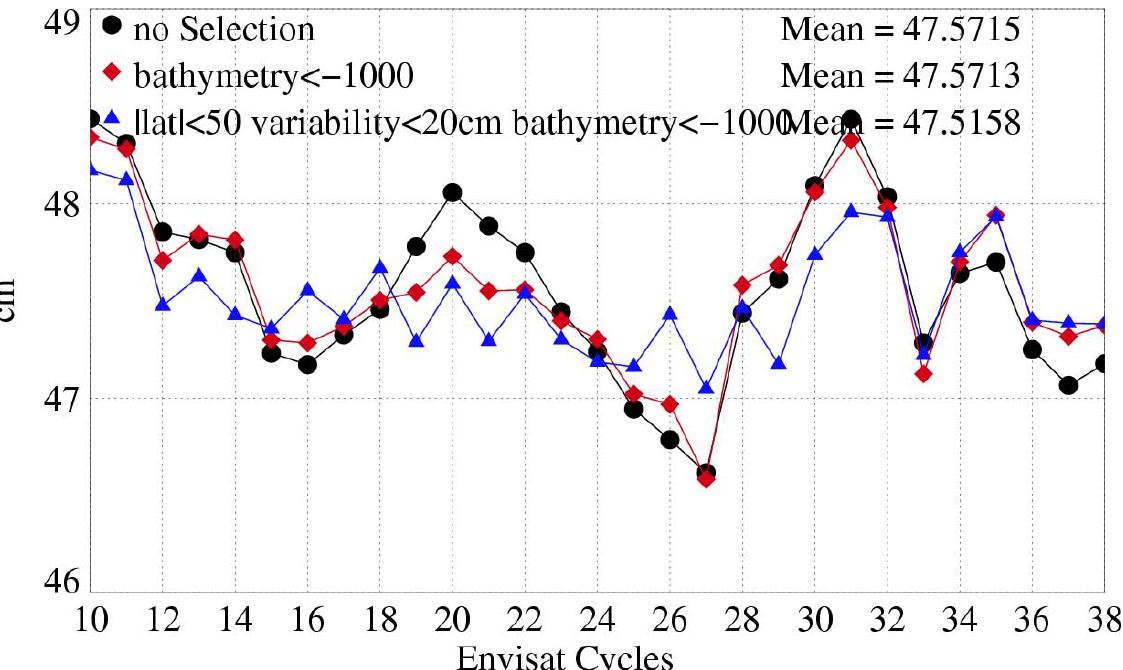
Figure 18. Mean of Envisat sea level depending on data selection. Dots: without any selection. Diamonds: shallow waters (1000 m) are excluded. Triangles: shallow waters excluded, latitude within [-50S, +50N], high ocean variability areas